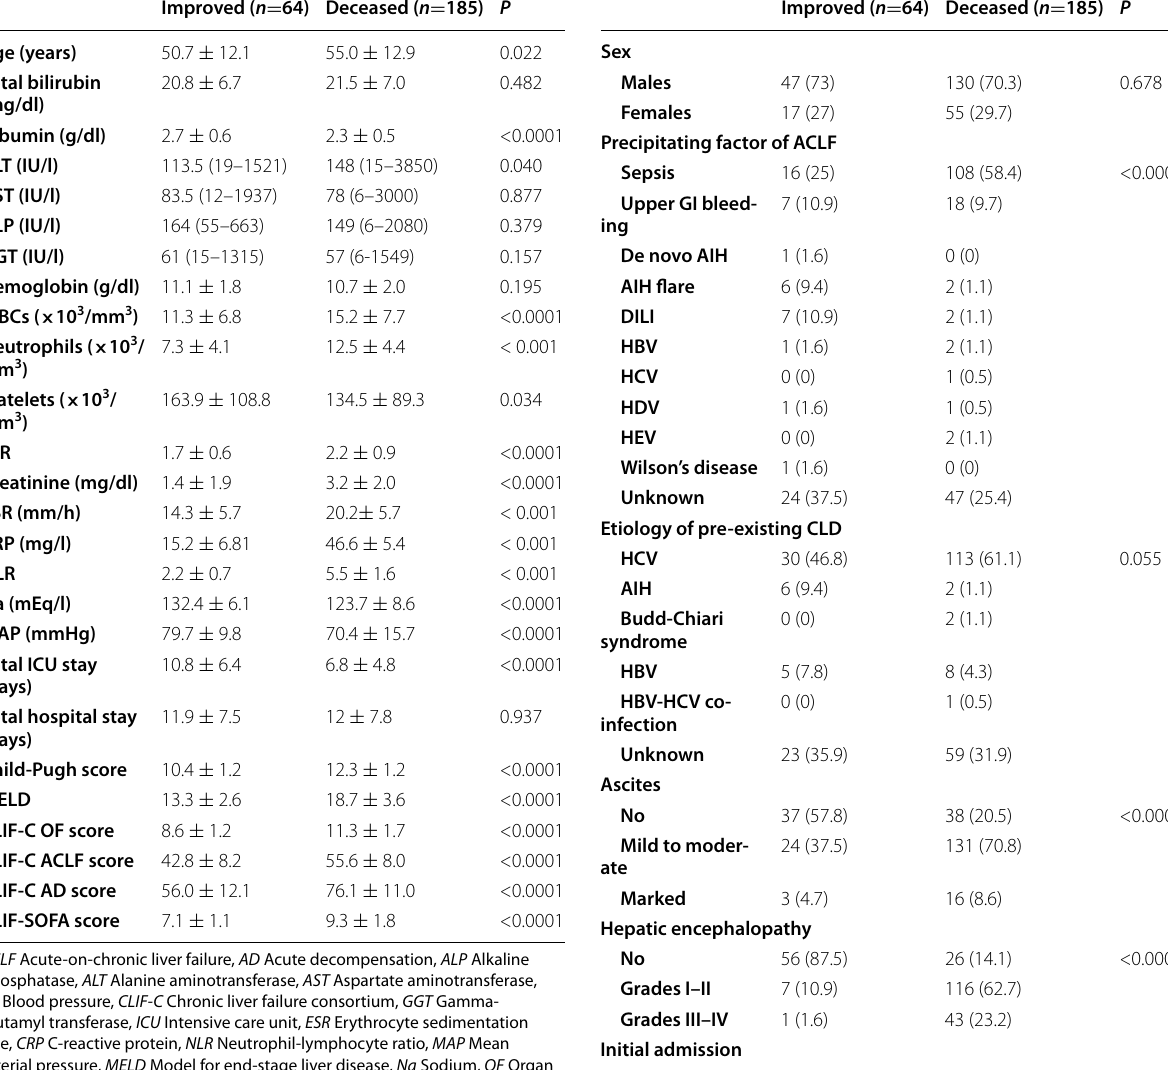
Table 3 Comparison between improved and deceased groups regarding quantitative variables